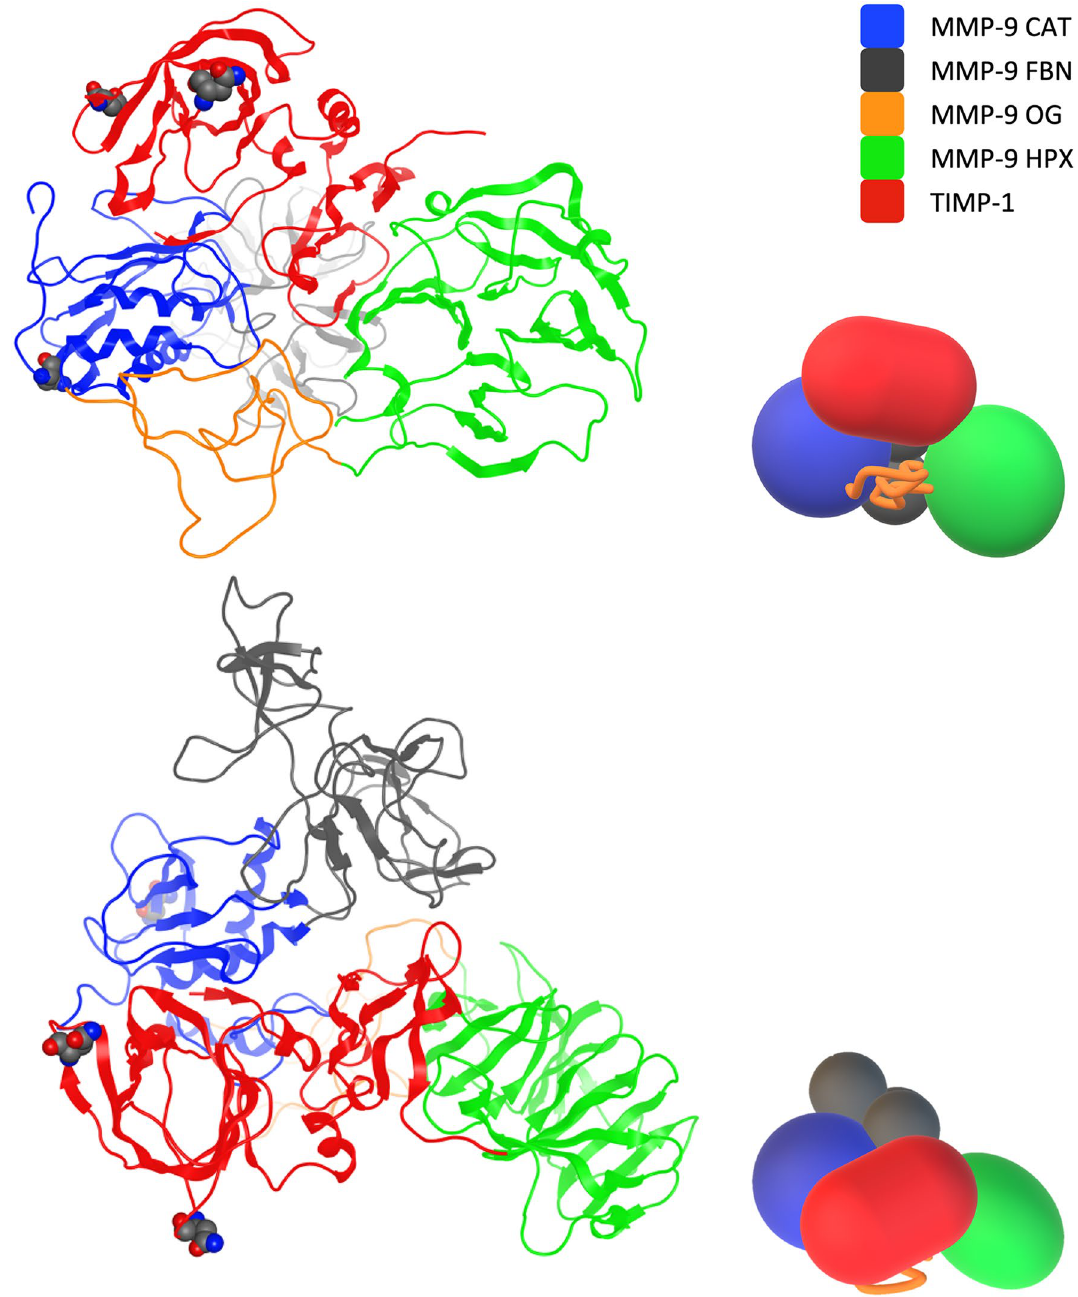
mutual arrangement. Catalytic (blue), fibronectin (grey), OG (orange), and hemopexin (green) domains form a compact structure. TIMP-1 (red) forms contacts with the catalytic, fibronectin, and hemopexin domains. Amino acids undergoing N-glycosylation are shown as Van der Waals spheres. The bottom images are rotated 90 degrees around the horizontal axis, in relation to the top